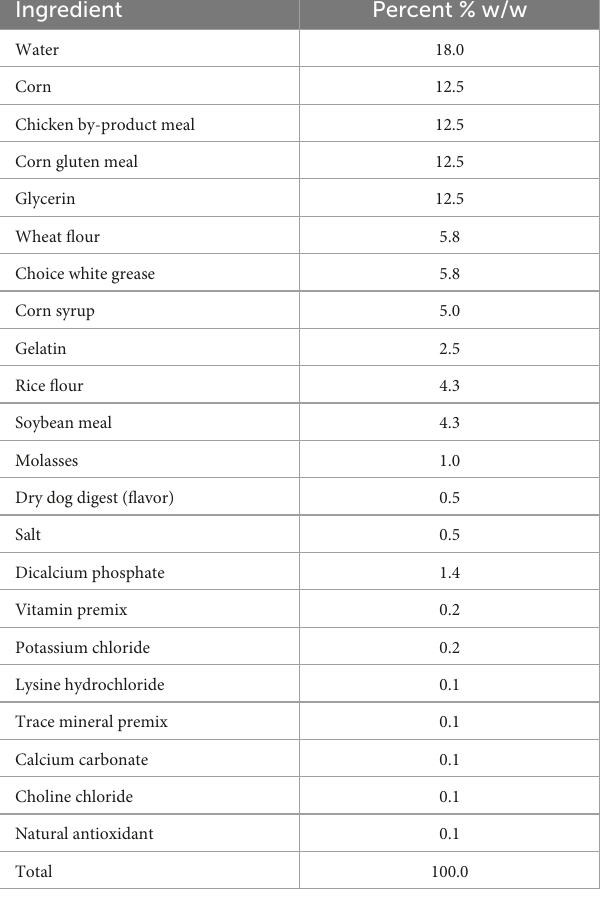
TABLE 1 Formula used for manufacturing the model semi-moist pet food.